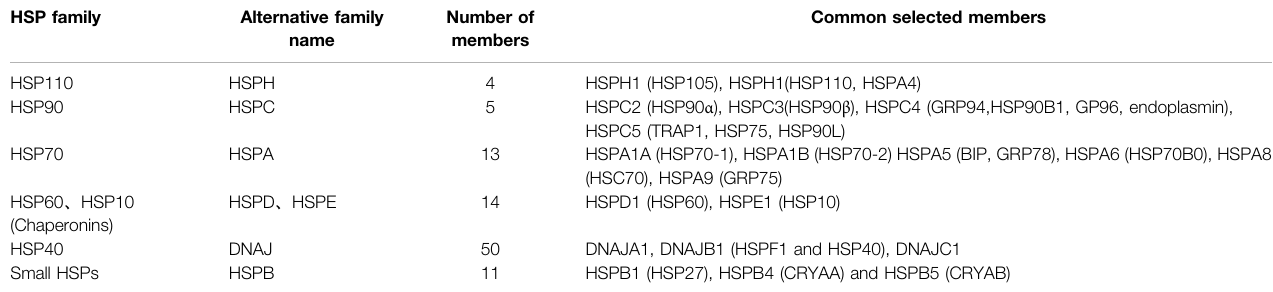
TABLE 1 | Heat shock protein family and its common members (Li et al.,